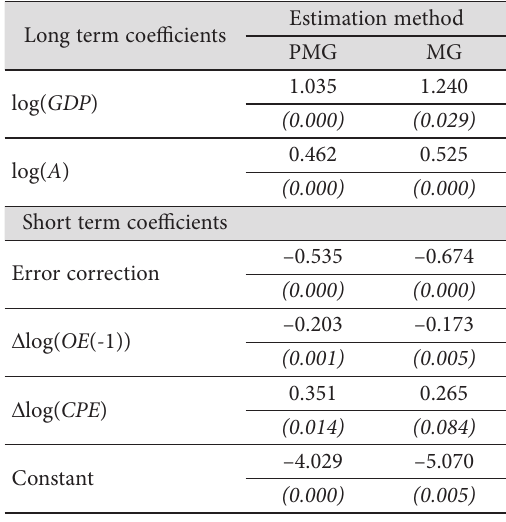
Table 4. Operating income estimation